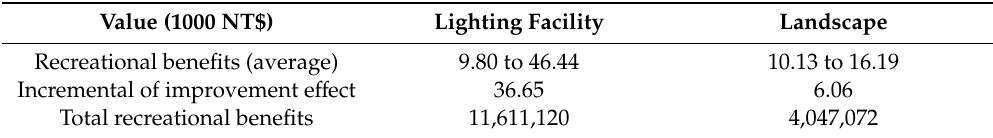
Table 5. Recreational benefits and programs e ff